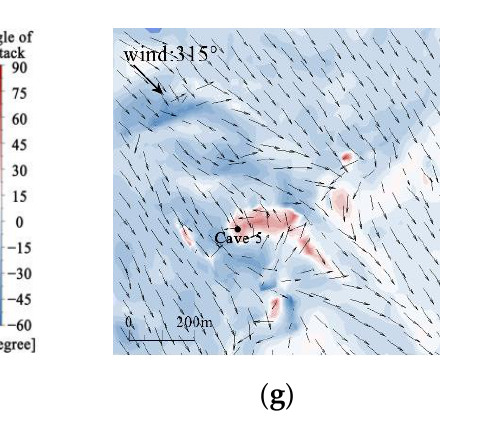
Figure 17. Contours of the simulated pressure around Cave 5 for the inlet wind directions of 45°, ( a ) without shelterbelt; ( b ) with shelterbelt. The rectangular in black line represents the position of shel- terbelt.